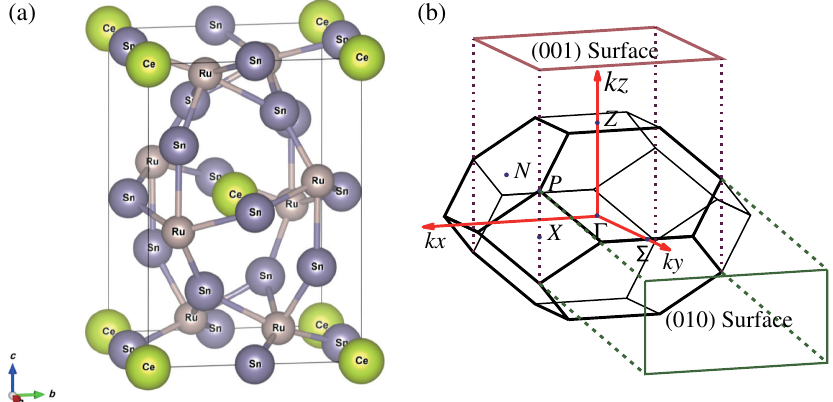
FIG. 1. Crystal structure and Brillouin zone (BZ). (a) The crystal symmetry of CeRu 4 Sn 6 . (b) The bulk BZ and the projected surface BZ for both (001) and (010)